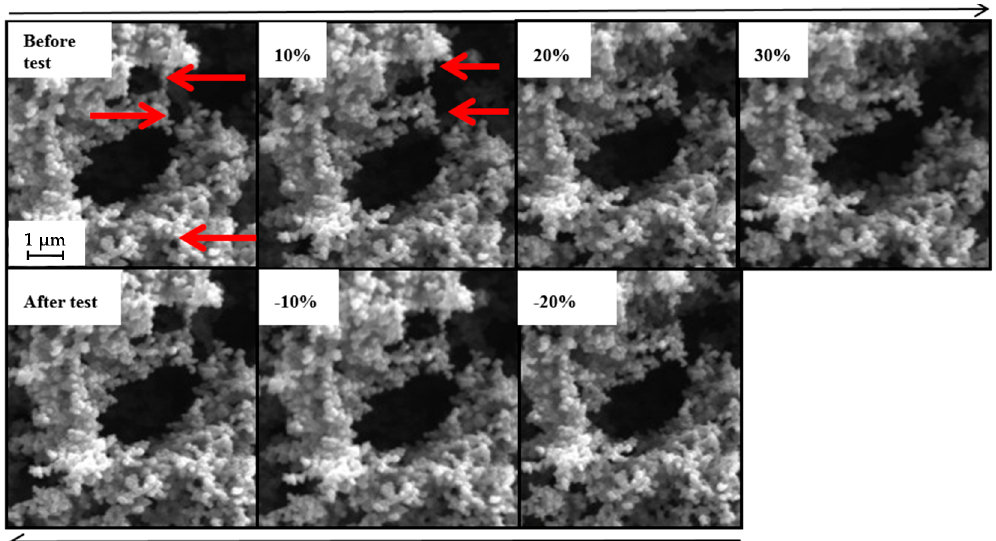
Figure 11. In-situ compression test in SEM of the super-flexible carbon aerogel. The deformation of the sample up to 30% is completely elastic. Three positions, marked with red arrows, show opening, closing, and deformation of pores. After unloading the pores of different size come back to the initial size and shape.